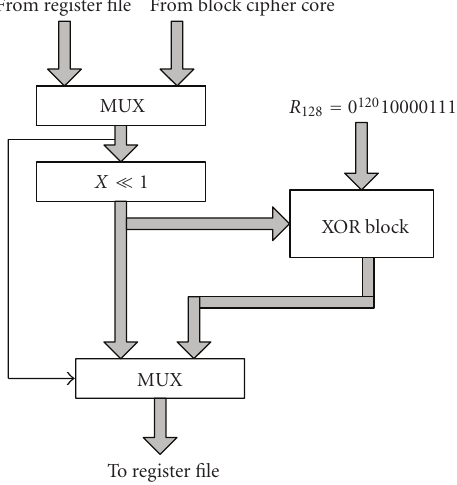
Figure 3: Initial unit.